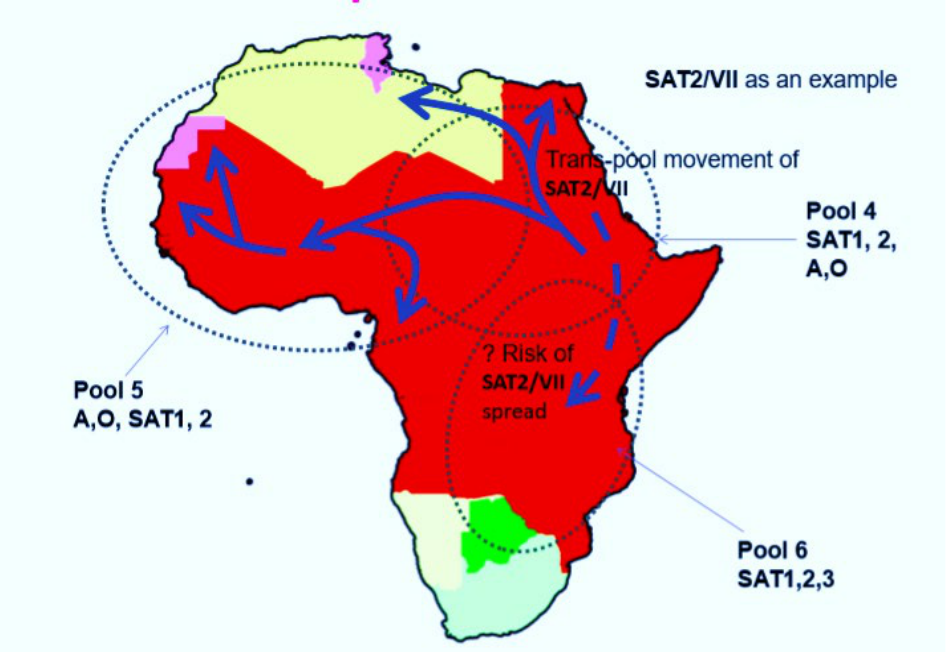
Figure 2. Incursionary features of FMDV serotype SAT2. In this map, SAT2 topotype VII was taken as an example. The directional arrows on the map show the epidemiological dynamics of SAT2 across different African regions, jumping the WOAH demarcated pools.